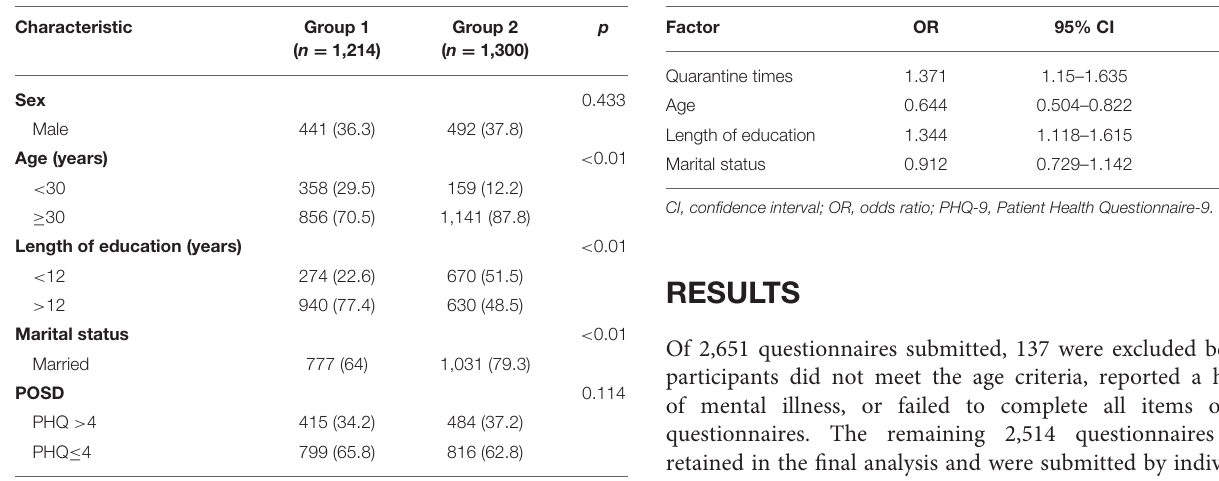
TABLE 1 | Demographic characteristics of participants stratified based on quarantine times.